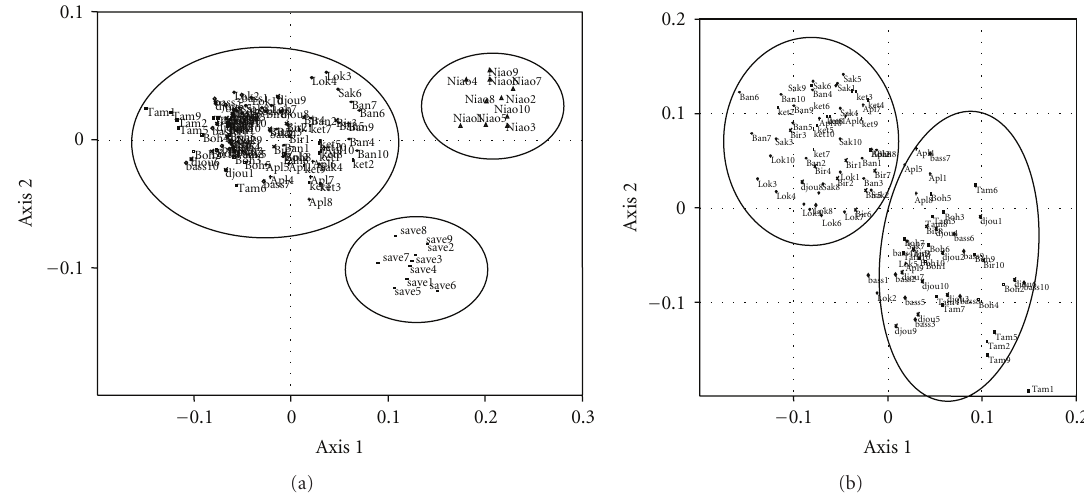
Figure 2: Projection of individuals of Milicia excelsa in the space of the first and second principal components. Sak = Sakete; Ket = Ketou; Tam = Tamarou; Bir = Biro; Djo = Djougou; Bas = Bassila; Ban = Bante; Boh = Bohicon; Nia = Niaouli; Apl = Aplahoue; Lok = Lokossa; and Sav = Save . A = first PCA and B = partial PCA.